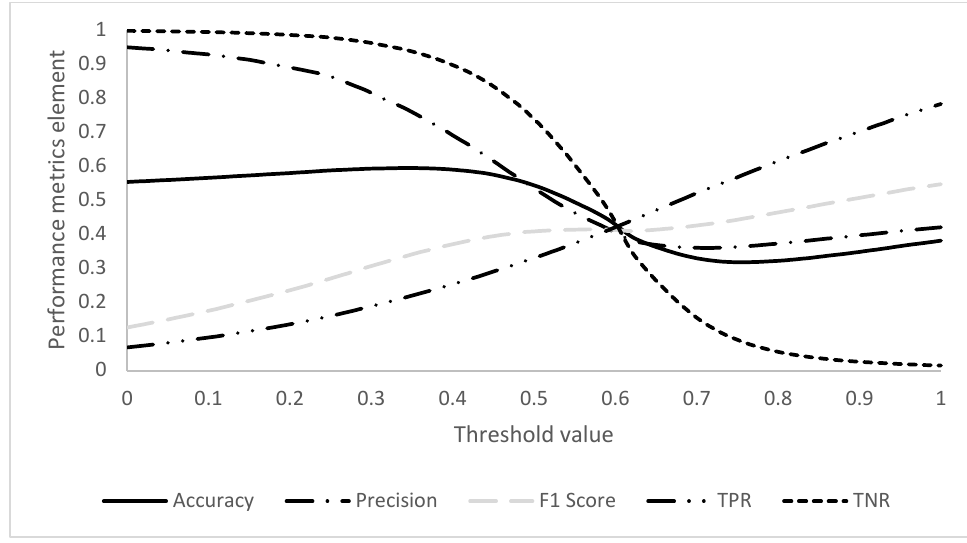
Figure 10. Influence of threshold value on the performance metric elements.